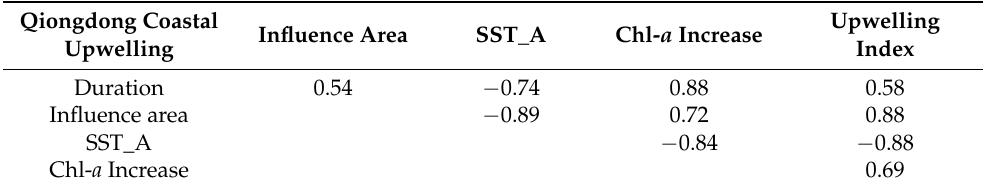
Upwelling Index